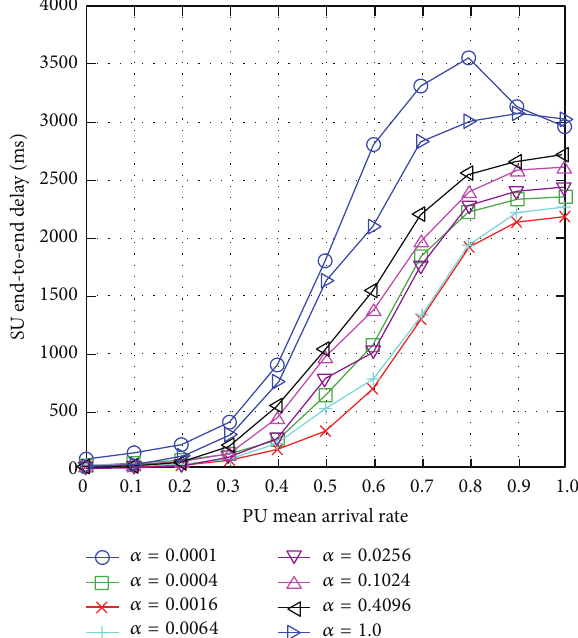
Figure 15: SU end-to-end delay for varying learning rate 𝛼